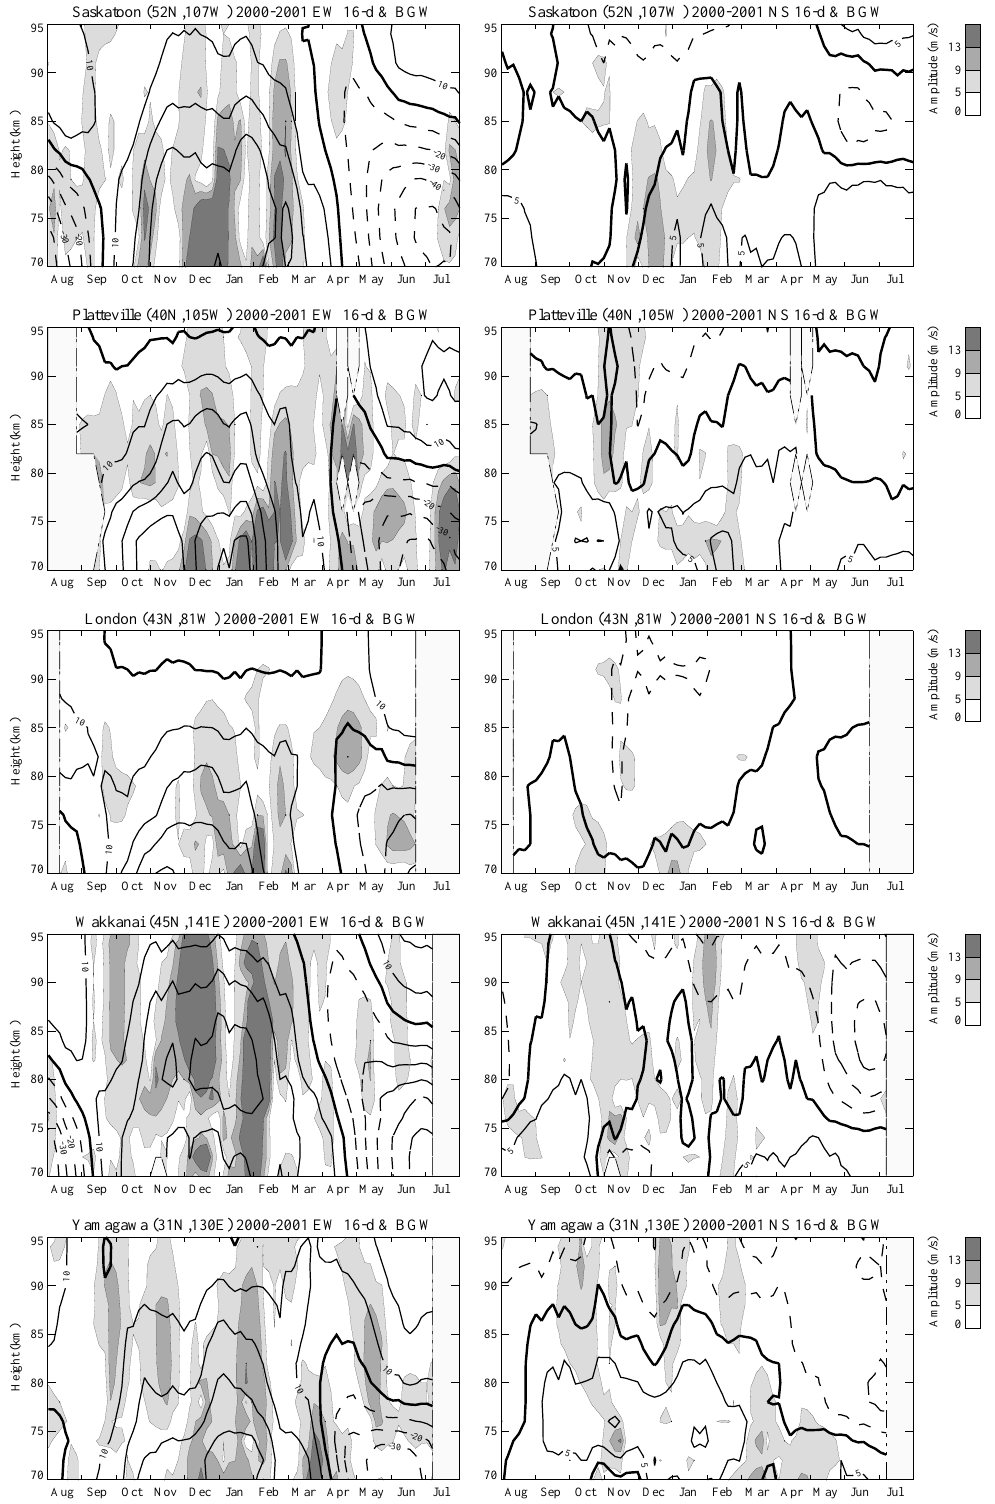
Fig. 6. Annual contours of wave amplitudes as functions of height versus time for the zonal and meridional (EW, NS) components of the 16-d PW: plots for Saskatoon, London, Platteville, Wakkanai and Yamagawa are shown. The background mean winds are shown by continuous or dashed lines. Analysis details are provided in Sect.